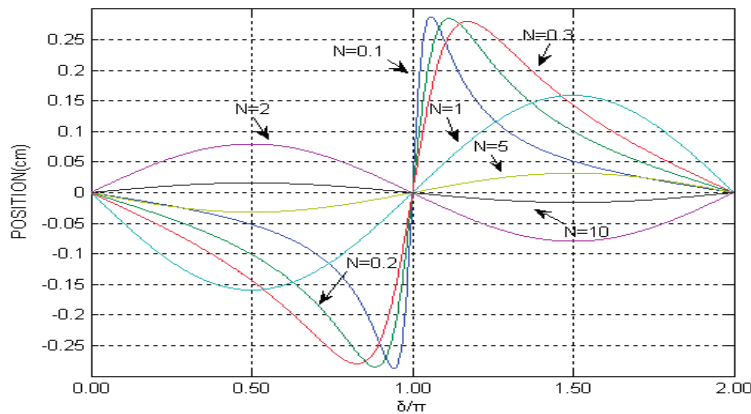
Figure 1. Centroid position versus interference fringes phase difference for some values of N.